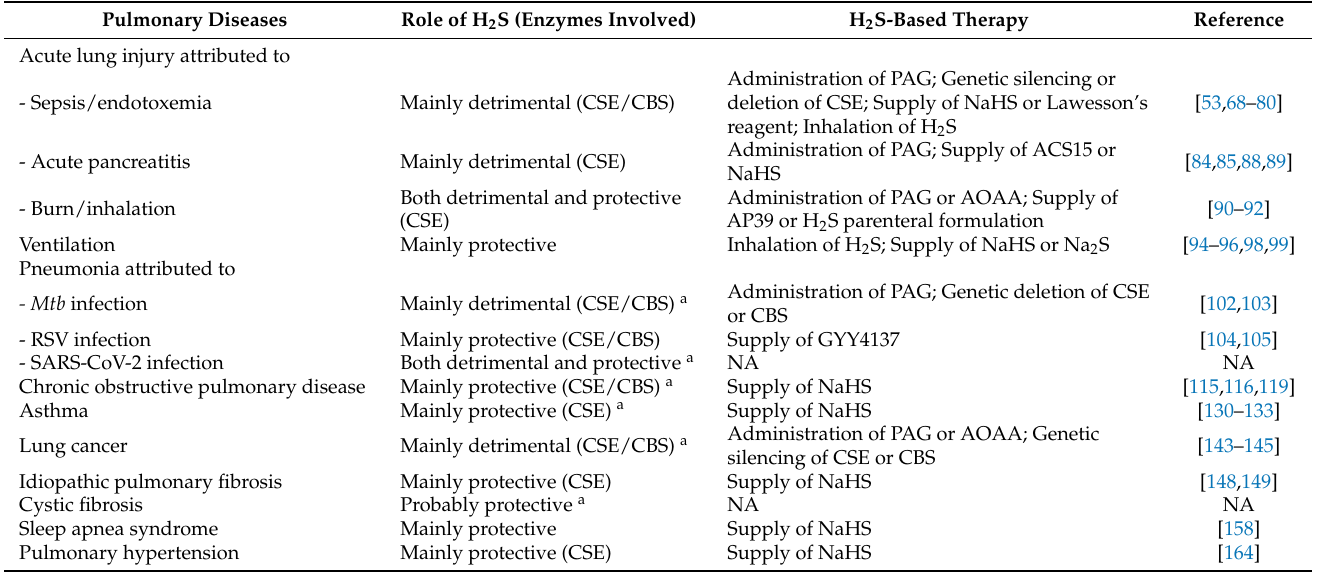
Figure 3. The schematic overview of the roles played by H 2 S as a biological mediator and a therapeutic target in pulmonary diseases. In living organisms, in response to pathological insults, programmed cell death, oxidative stress and inflammation can lead to each other (blue double-headed arrow), which triggers a local auto-amplification loop (black dashed circle). Under pathological conditions, H 2 S can either promote (black solid arrow) or inhibit (red dashed arrow) programmed cell death, oxidative stress and inflammation. As programmed cell death, oxidative stress and inflammation are three important biological processes extensively involved in maintaining the homeostasis of the respiratory system, H 2 S, functioning as a significant biological mediator, has been linked to the pathogenesis of several pulmonary diseases. Moreover, H 2 S has also been demonstrated as a potential therapeutic target in many pulmonary diseases. Table 3. A brief summary of the major role of H 2 S and H 2 S-based therapy in pulmonary diseases.